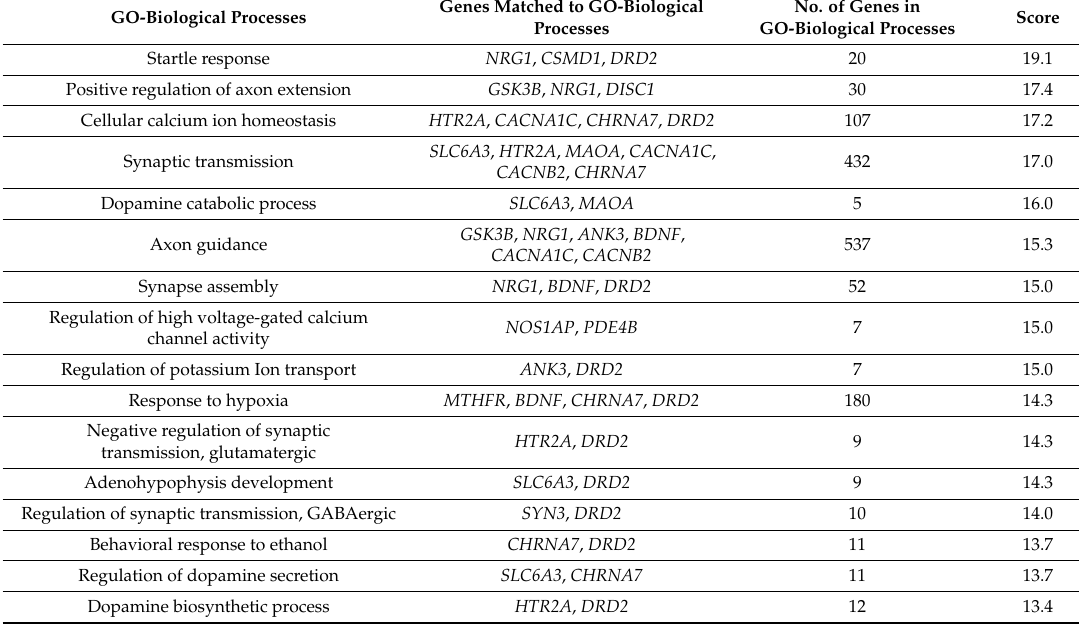
Table 4. GeneAnalytics program mapping of gene ontology (GO) biological processes with high match scores to 23 overlapping genes for autism spectrum disorder, bipolar disorder and